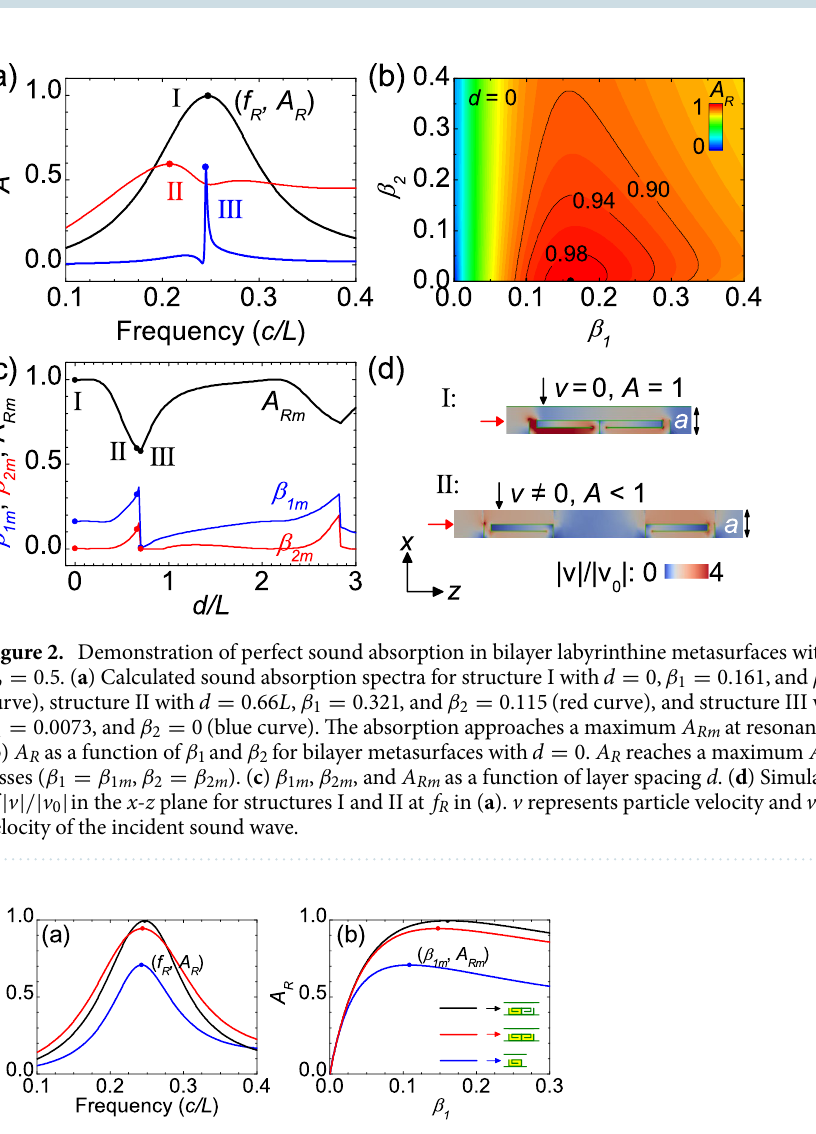
Figure 3. Comparison of sound absorption in three different metasurfaces. ( a ) Calculated sound absorption spectra for a bilayer metasurface with β 1 = 0.161 , β 2 = 0 and d = 0 (black line), a bilayer metasurface with β 1 = β 2 = 0.148 and d = 0 (red line), and a single-layer metasurface with β 1 = 0.108 (blue line). All the metasurfaces have an open area ratio p o = 0.5 . The absorption approaches a maximum A R at resonant frequency f R . ( b ) A R as a function of β 1 for the three